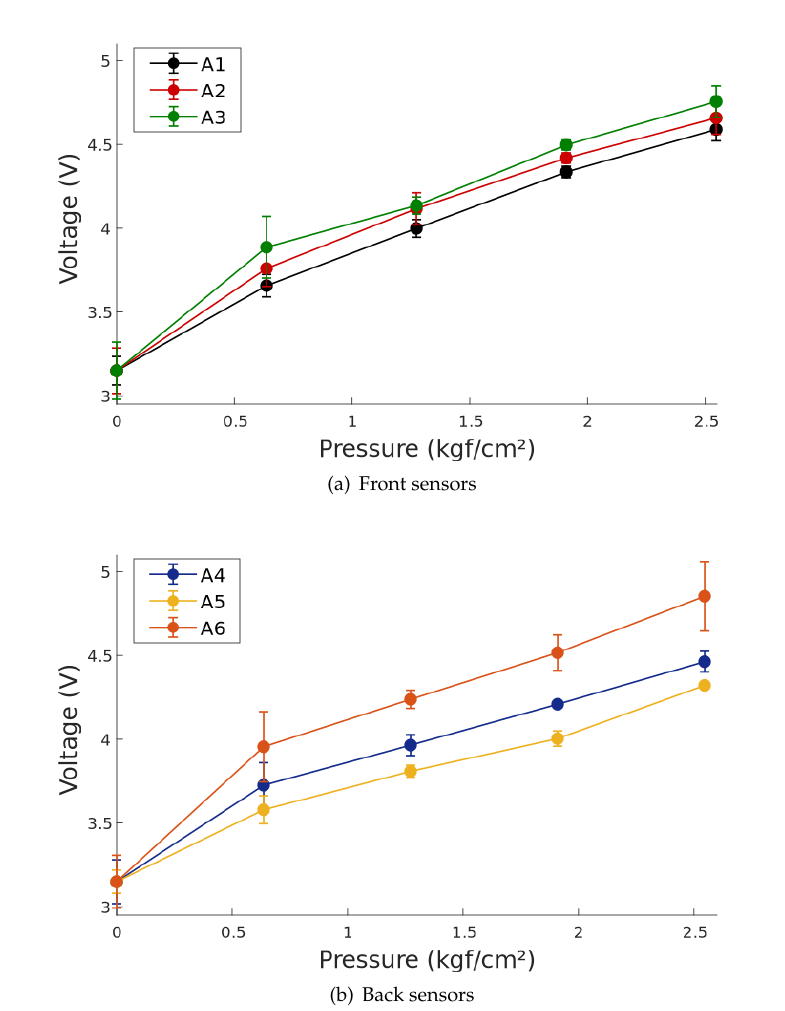
Figure 14. Linear Characterization of sensors showing measurement divergence. ( a ) Error points on